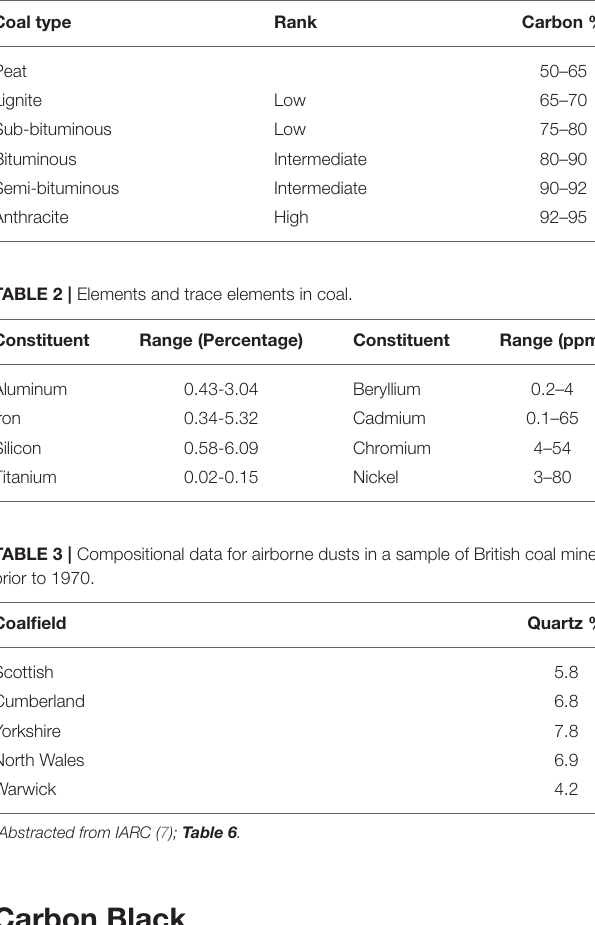
TABLE 1 | Carbon contents of coal.